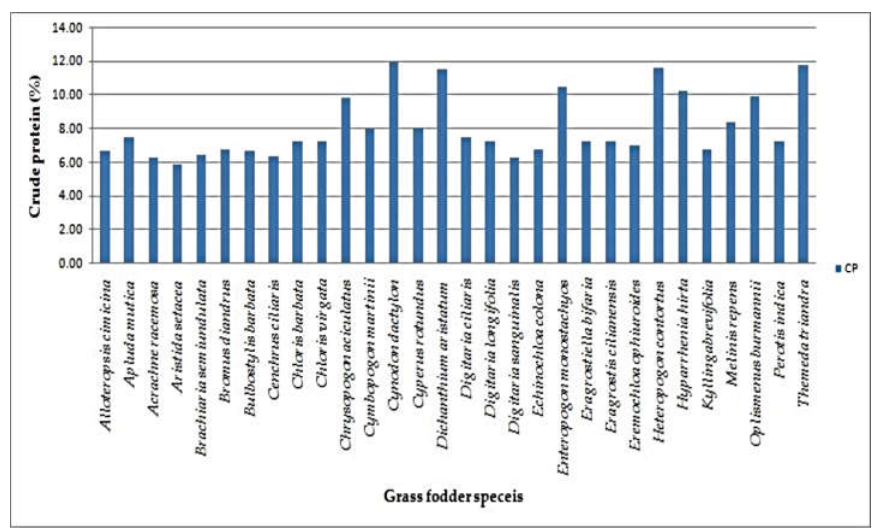
Figure 3. Crude protein content of native grass fodder species.